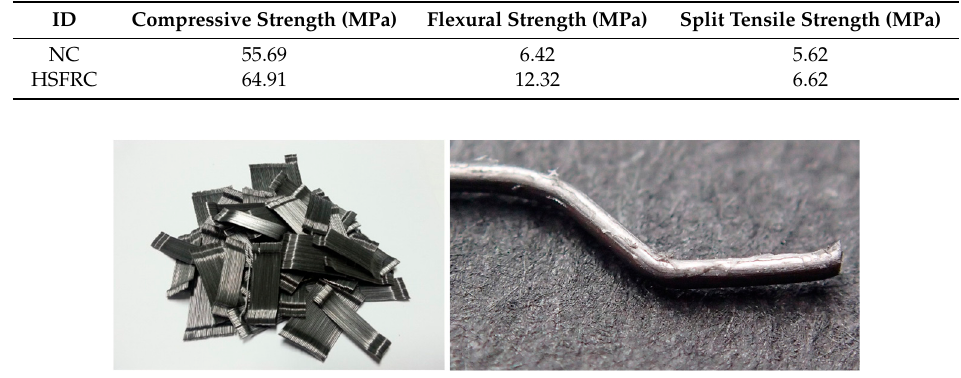
Table 5. Compressive, flexural, split tensile strength of concrete at the age of 28 days.